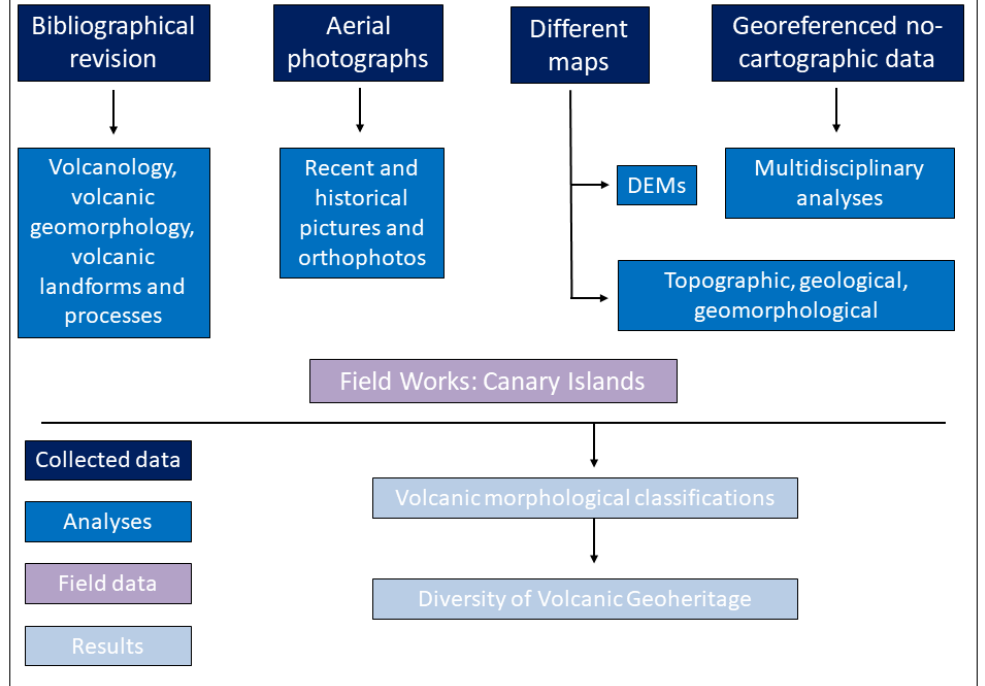
Figure 2. General methodology to assess the diversity of volcanic geoheritage.